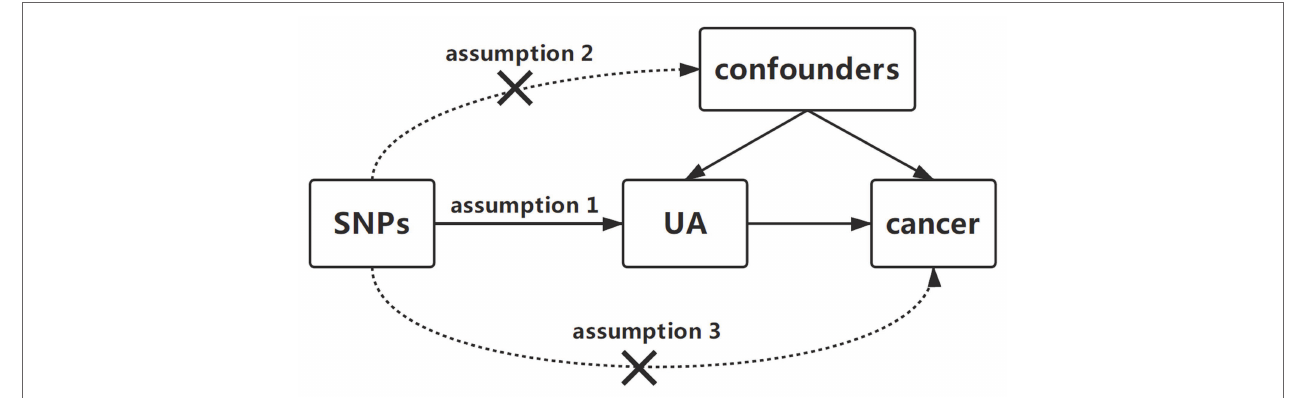
FIGURE 1 | Diagram of two-sample Mendelian randomization analysis of serum uric acid levels and cancer risk. Three key assumptions in the Mendelian randomization analysis are as follows: (1) the SNPs should be related to serum UA levels, (2) the SNPs should be independent of confounders, and (3) the SNPs could affect cancer only by UA. SNP, single-nucleotide polymorphism; UA, uric